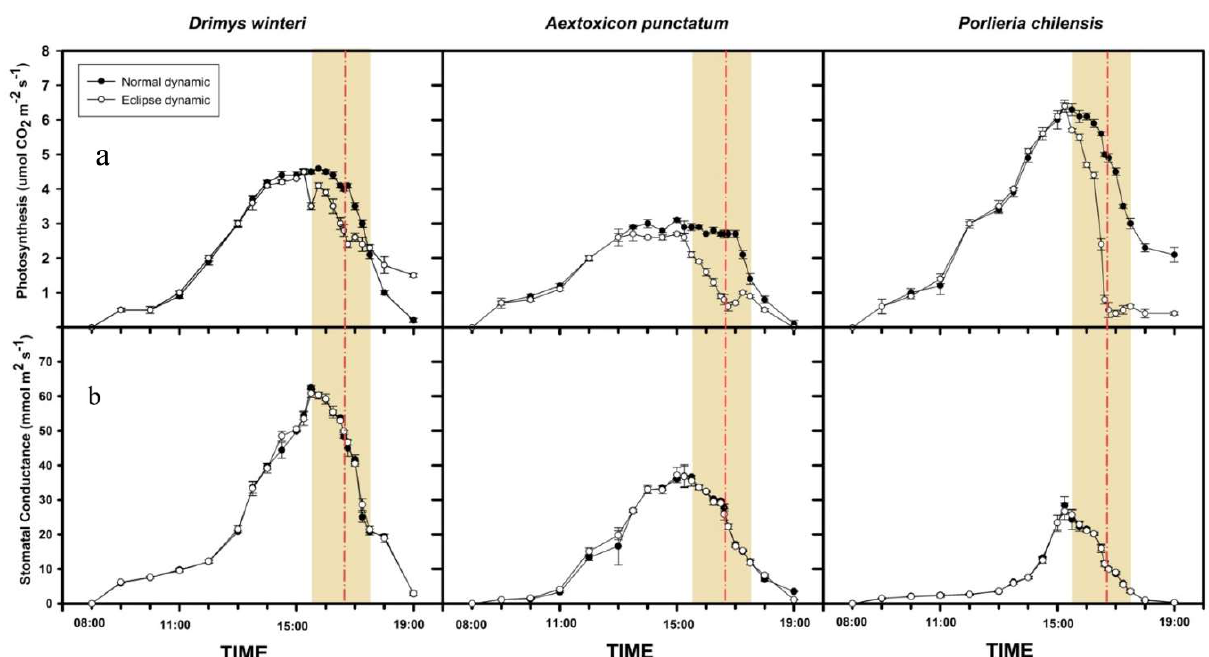
Figure 1. Daily photosynthesis( a ) and stomatal conductance ( b ) during a control (non-eclipse) and an eclipse dayin Drimys winteri (shade-tolerant), Aextoxicon punctatum (intermediate), and Porlieria chilensis (shade-intolerant). Normal dynamics (non-eclipse day, filled circles) and eclipse dynamics (eclipse day, open circles). Shaded zones represent partial solar eclipse. The red dashed vertical line represents total solar eclipse (2 July 2019). Mean ± 1 SD are shown.